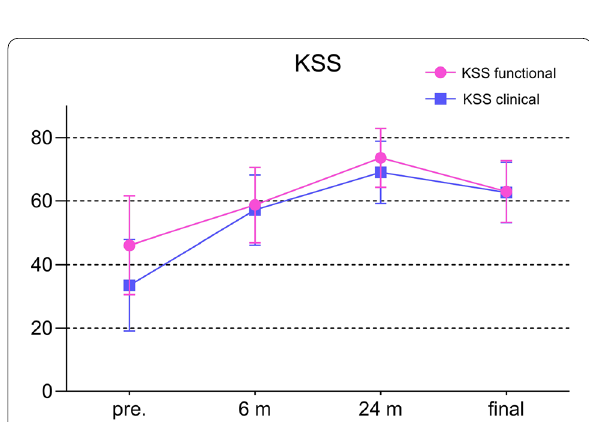
Fig. 2 Trends in the clinical KSS and functional KSS, with the results obtained preoperatively, at 6 and 24 months postoperatively, and at the final follow-up shown. KSS Knee Society Score, Pre. preoperative